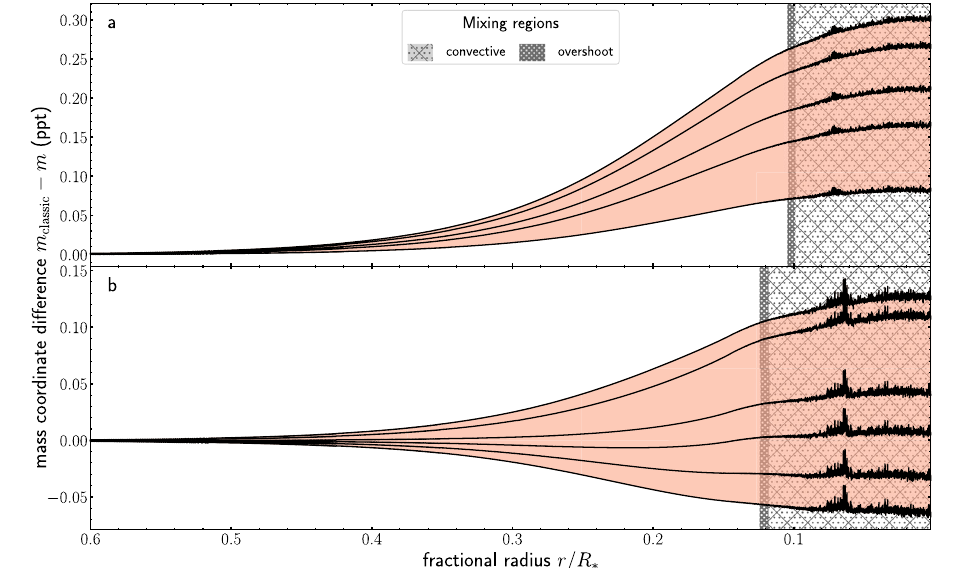
Fig. 6 | Differences in stellar structure between the disk-mediated accretion models and the classical model. The mass coordinate as a function of the frac- tional stellar radius. The grey shaded areas mark the extension of the convective coreandtheovershootingregionaccordingtothelegend.Thesalmonshadedarea marks the range of mass coordinate differences reached by the 34 disk-mediated models. a Differencesinstructureatthepre-mainsequencestage.Selectedmodels